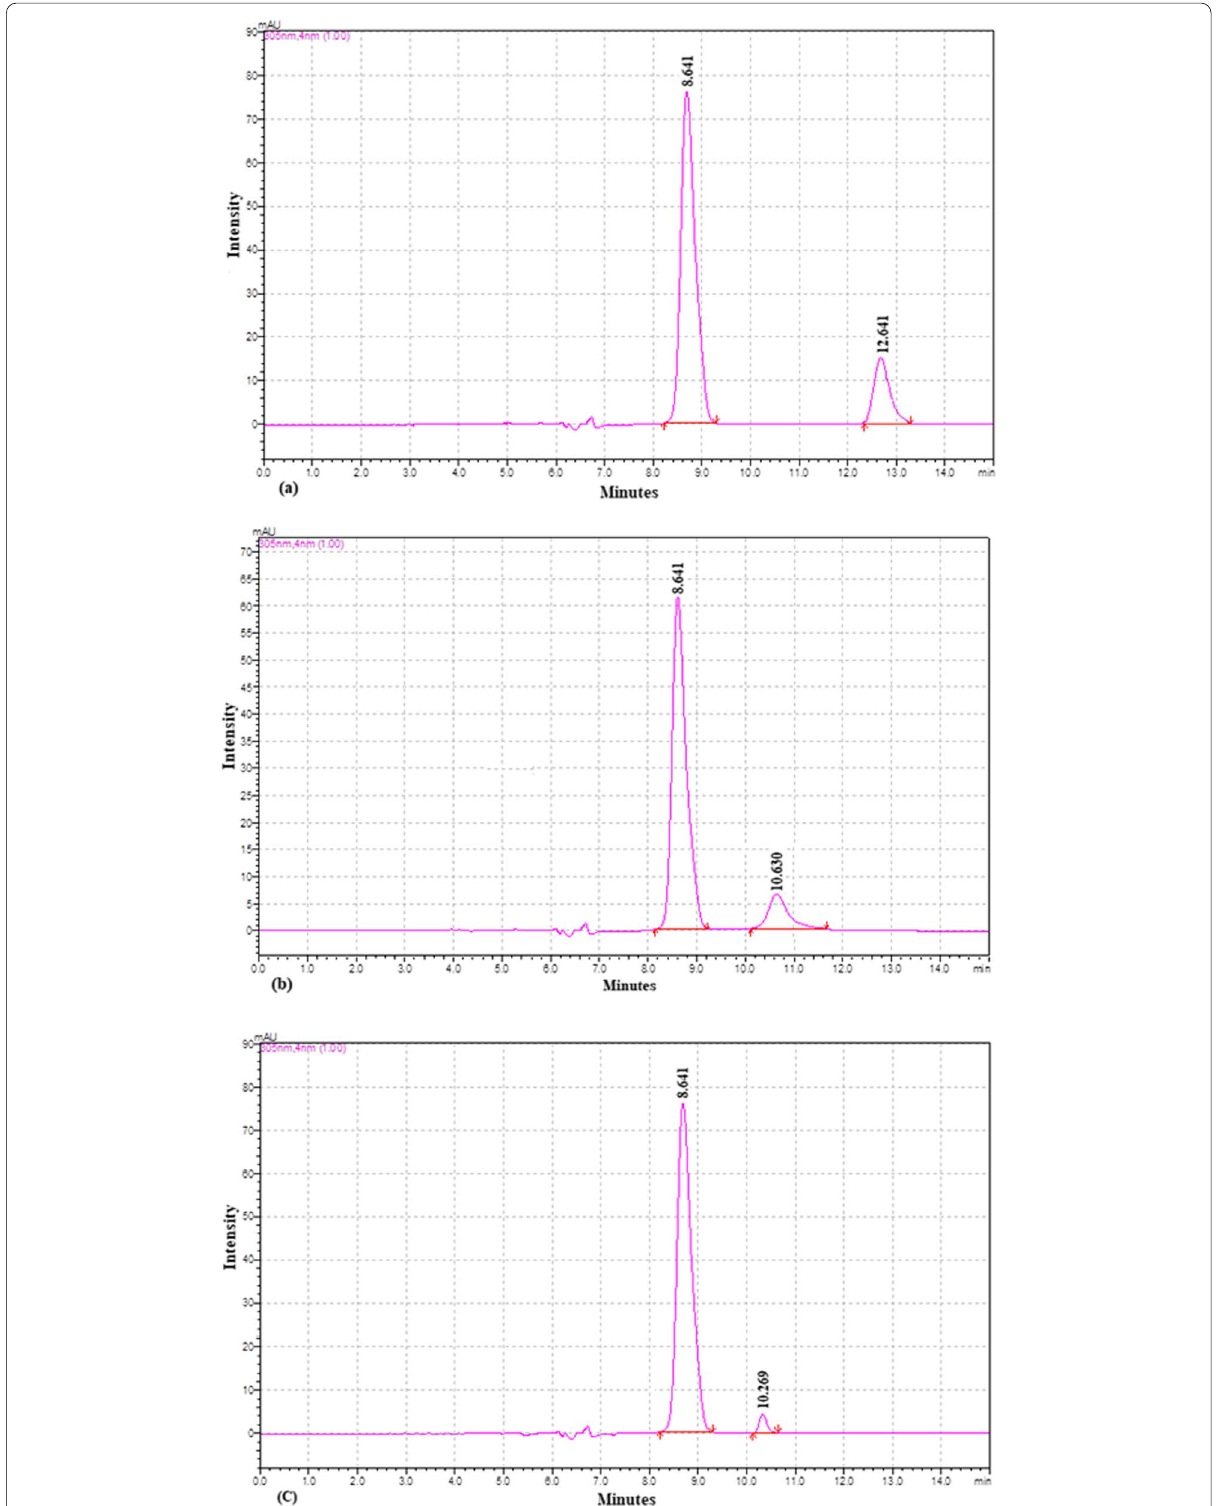
Fig. 3 Showing chromatogram of standard solution of mifepristone after forced degradation studies, a acidic hydrolysis (0.1 N methanolic HCl reflux at 70 °C for 3 h), b alkali hydrolysis (0.5 N methanolic NaOH reflux at 70 °C for 5 h), c oxidative degradation with 6% H 2 O 2 at room temperature for 8